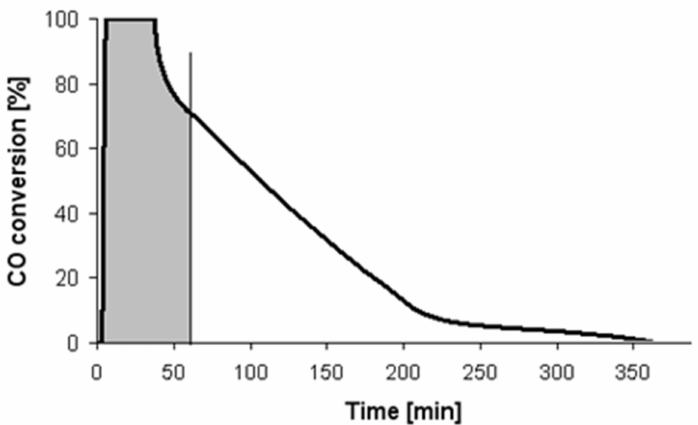
Figure 7. The profiles of CO conversion changes vs. time at room temperature over Pt/Al 2 O 3 catalyst (sample